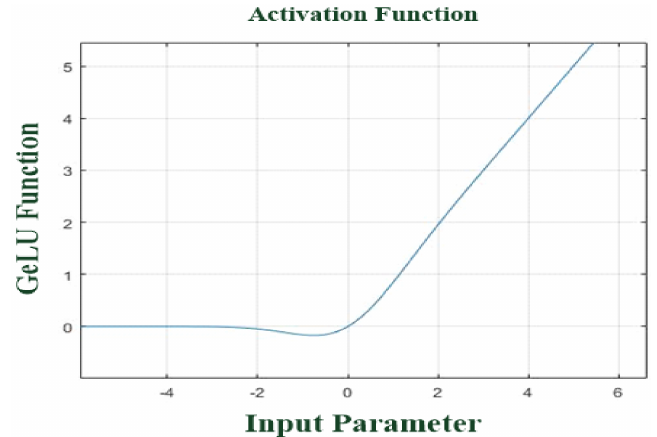
Figure 3. GeLU activation function in each hidden